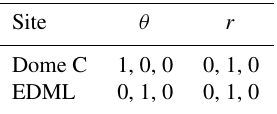
Table 3. The constant l 1 , l 2 , l 3 for ice fabric parameters θ and r at Dome C and